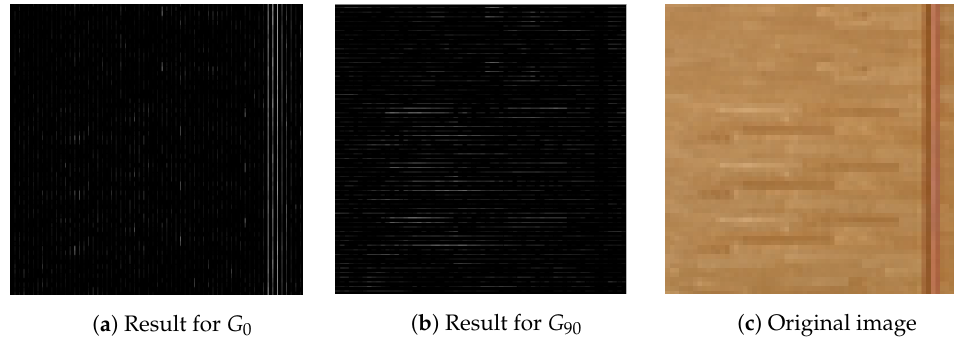
Figure 5. Direction error example. Table 1. Magnitude of the four directions in Figure